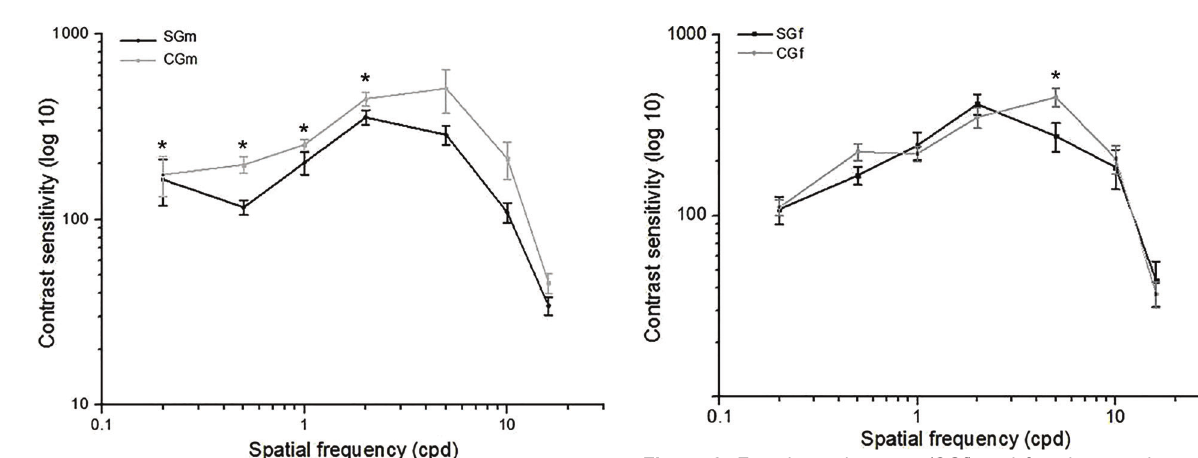
Figure 2. Female study group (SGf) and female control group (CGf) contrast sensitivity curve. Data are reported as the means and vertical lines show the standard error of the mean for each spatial frequency (0.2, 0.5, 1.0, 2.0, 5.0, 10.0 and 16.0 cpd). *P o 0.05 (Mann-Whitney